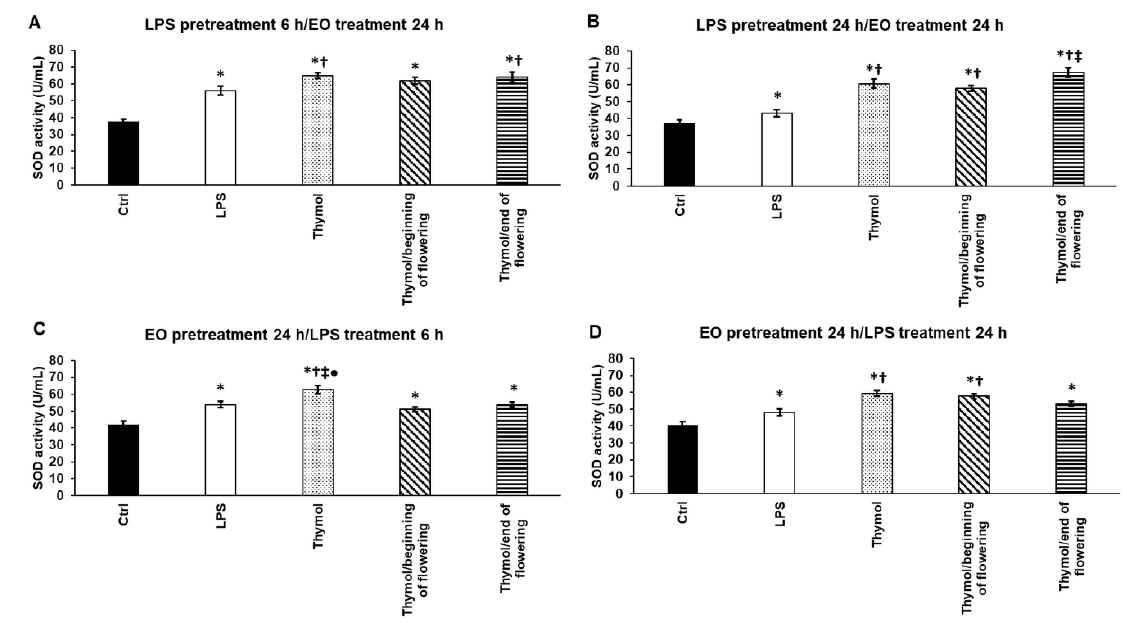
Figure 5. Determination of the effects of thymol and TEOs on superoxide dismutase (SOD) activity of the THP-1 cells. As a control, the THP-1 cells were treated with DMSO, the carrier of EOs or distilled water, and the solvent of LPS in the same order and for the same time as in the case of the EO and LPS pretreatments. For LPS treatment, the cells were treated with LPS for 6 h or 24 h, and then they were treated with 500-fold diluted DMSO for 24 h or were treated with DMSO for 24 h, and then LPS was added for 6 h and 24 h. For LPS pretreatment, the cells were treated with LPS for 6 h and 24 h, and then they were treated using 500-fold diluted thymol or TEOs for 24 h. For EO pretreatment, the cells were treated with 500-fold diluted thymol or TEOs for 24 h followed by LPS administration for 6 h and 24 h. SOD activity was measured with Superoxide Dismutase (SOD) Activity Assay Kit according to the protocol of the manufacturer and was expressed as U/mL. The bars represent mean values, and error bars represent standard deviation (SD) for three independent experiments (n = 3). The assays were carried out in triplicate in each experiment. Asterisk indicates p < 0.05 compared to control. Cross marks p < 0.05 compared to LPS treatment. Double cross shows p < 0.05 compared to TEO/beginning of flowering. Bullet marks p < 0.05 compared to TEO/end of flowering. Statistical analysis was carried out by two- way ANOVA followed by Scheffe’s post hoc test.